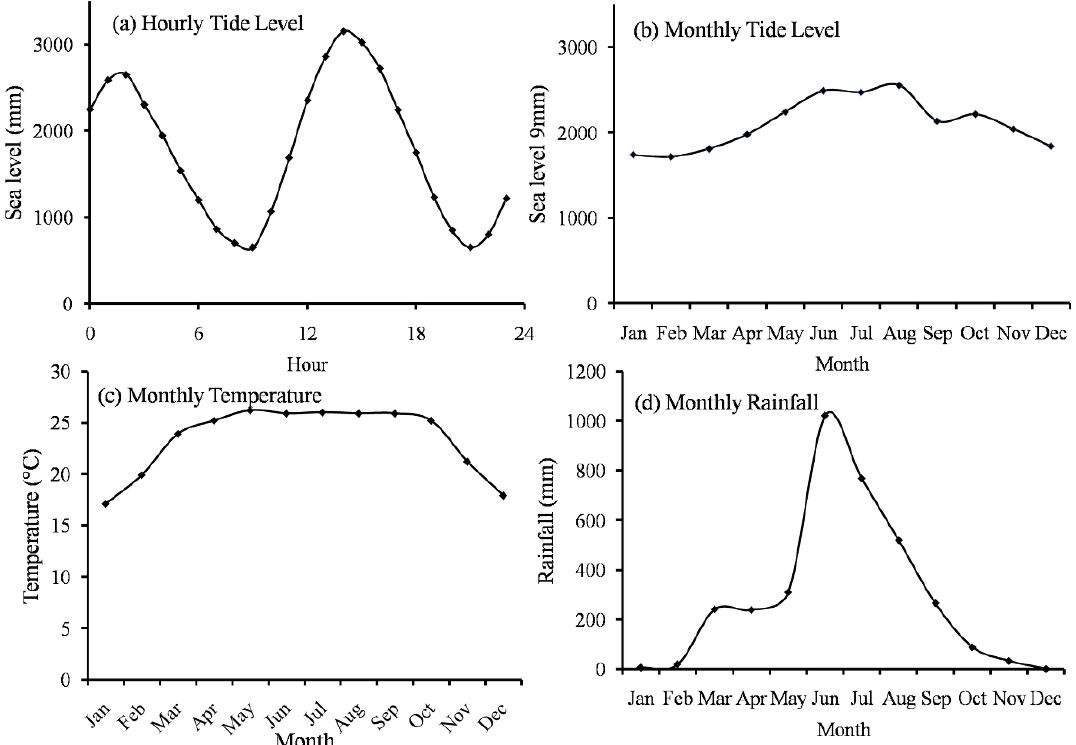
Figure 6. (a) Hourly sea level on December 19, 1999, (b) mean monthly sea level for the year 1999, Figure 6. ( a ) Hourly sea level on December 19, 1999, ( b ) mean monthly sea level for the year 1999, ( c ) (c) monthly temperature (degree Celsius) for 1991, and (d) monthly variation of rainfall (mm/day) monthly temperature (degree Celsius) for 1991, and ( d ) monthly variation of rainfall (mm/day) for for the year 1994 at the Cox’s Bazar station. the year 1994 at the Cox’s Bazar